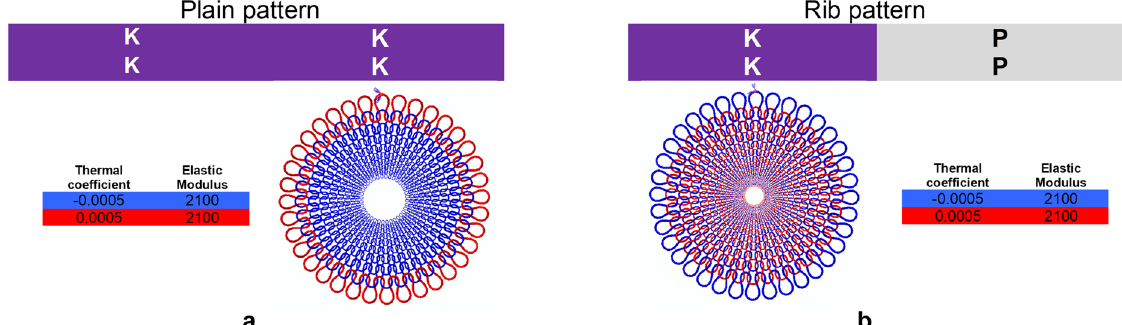
Figure 2. Basic architecture and material. ( a ) Plain knit pattern has only knit stitches (when seen in opp. to plane of figure purl stitches only) adjacent to each other as shown in the schematic on the top. Material properties defined using the color coding with blue representing negative thermal coefficient of expansion while red represents positive thermal coefficient of expansion with insert showing corresponding yarns color. ( b ) Rib knit pattern has knit stitches adjacent to purl stiches as shown in the schematic on the top. Material properties defined using the color coding with blue representing negative thermal coefficient of expansion while red represents positive thermal coefficient of expansion with insert showing corresponding yarns